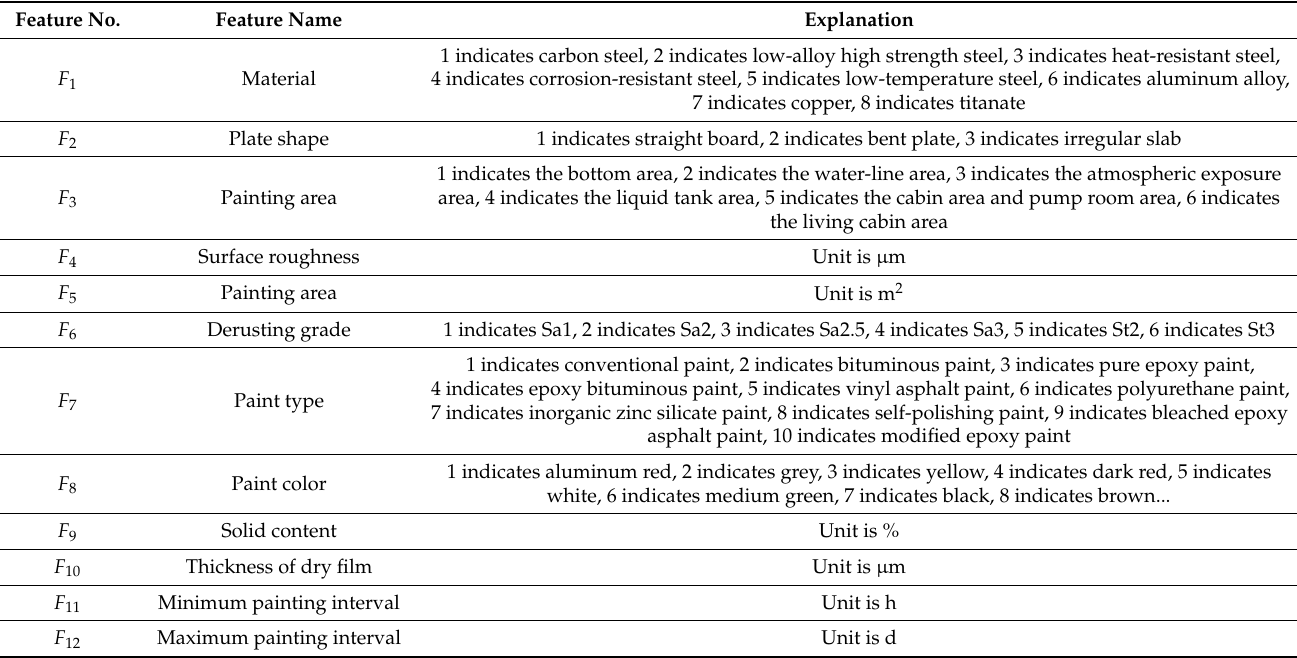
Table 3. Feature attributes of the painting